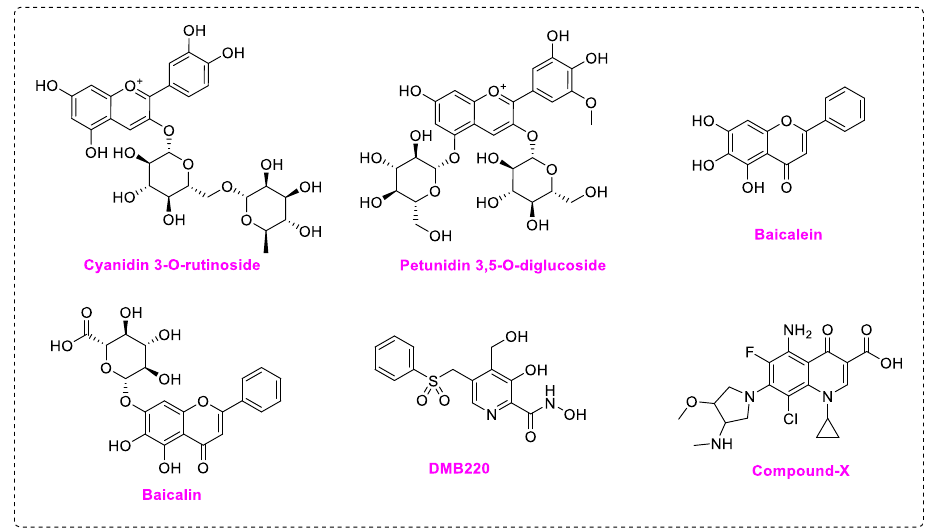
Figure 2. Structures of non-nucleoside inhibitors targeting SARS-CoV-2/DENV RdRp.